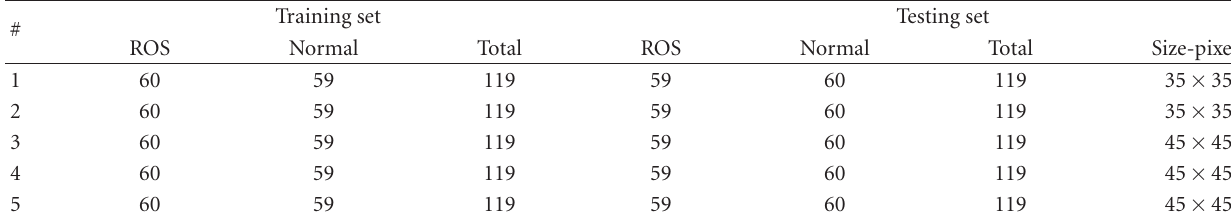
Table 1: Di ff erent sets used to evaluate the detection algorithm